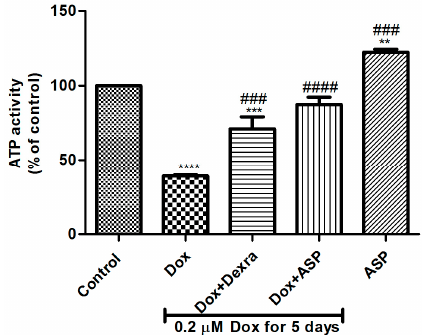
Figure 1. The effect of aspalathin (ASP) co-treatment on metabolic activity of H9c2 cells exposed to Doxorubicin. H9c2 cells were treated with 0.2 µM doxorubicin (Dox) alone (positive control) or co-treated in combination with either 20 µM dexrazoxane (Dexra) or 0.2 µM ASP daily for 5 days. Control samples were either exposed to media only or 0.2 µM ASP for 5 days. Results are expressed as the mean ± SEM of three independent biological experiments, each with three technical replicates ( n = 9). *** p ≤ 0.001, **** p ≤ 0.0001 versus control and ### p ≤ 0.001, #### p ≤ 0.0001 versus Dox.